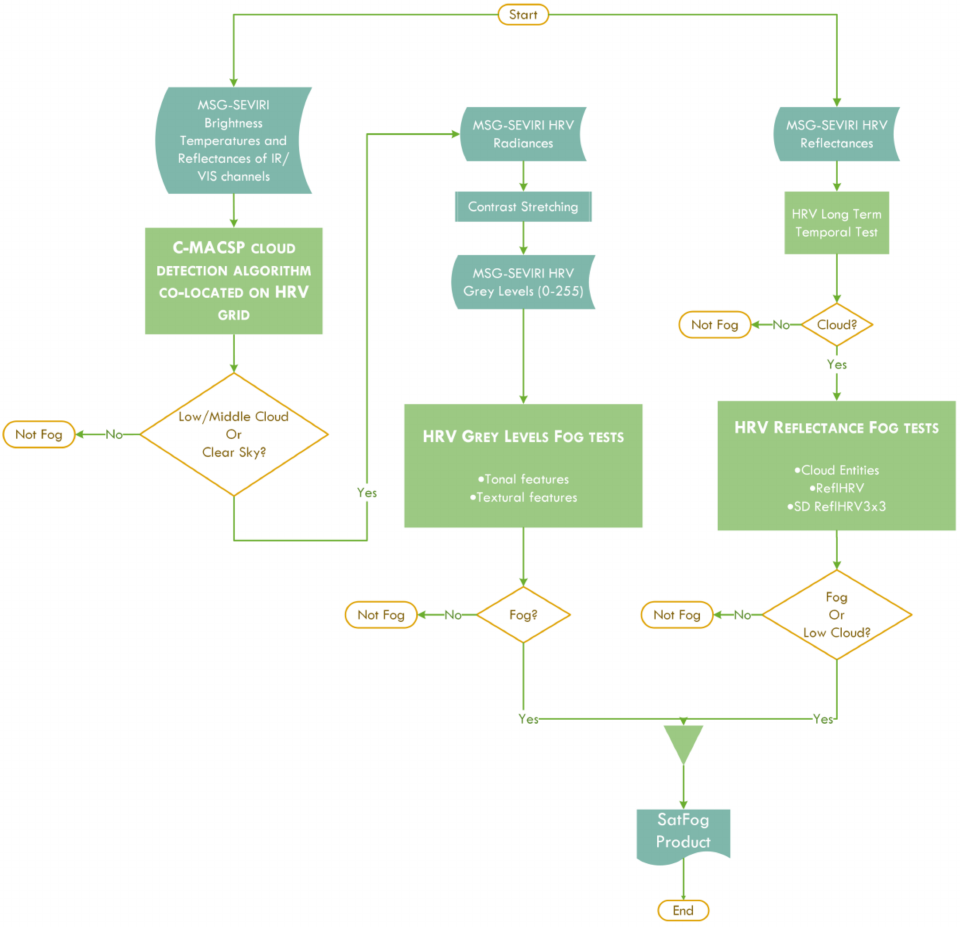
Figure 1. Meteosat Second Generation-Spinning Enhanced Visible and Infrared Imager (MSG-SEVIRI) SatFog